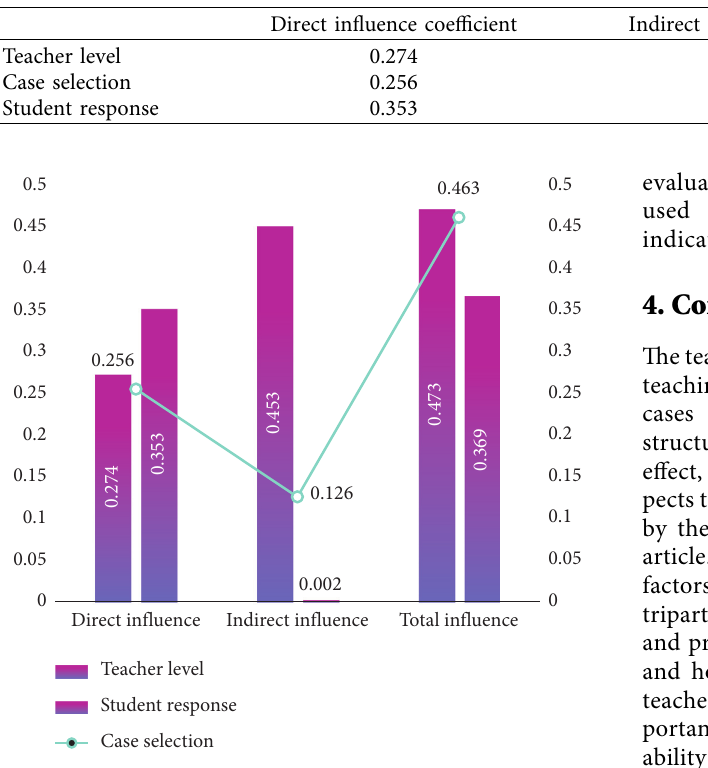
Figure 8: The influence of each latent variable on teaching